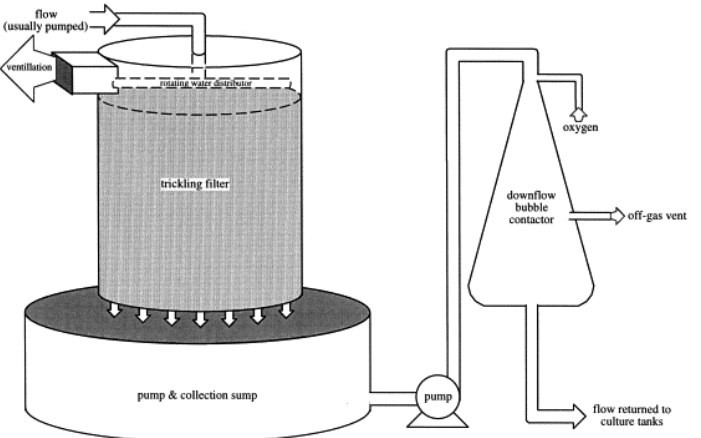
Figure 3. Schematic representation of the trickling filter used in RASs. Figure reprinted from [53]. Copyright (2000) Aquaculture Engineering on Science Direct. Licensed under CC BY-NC-ND 4.0.